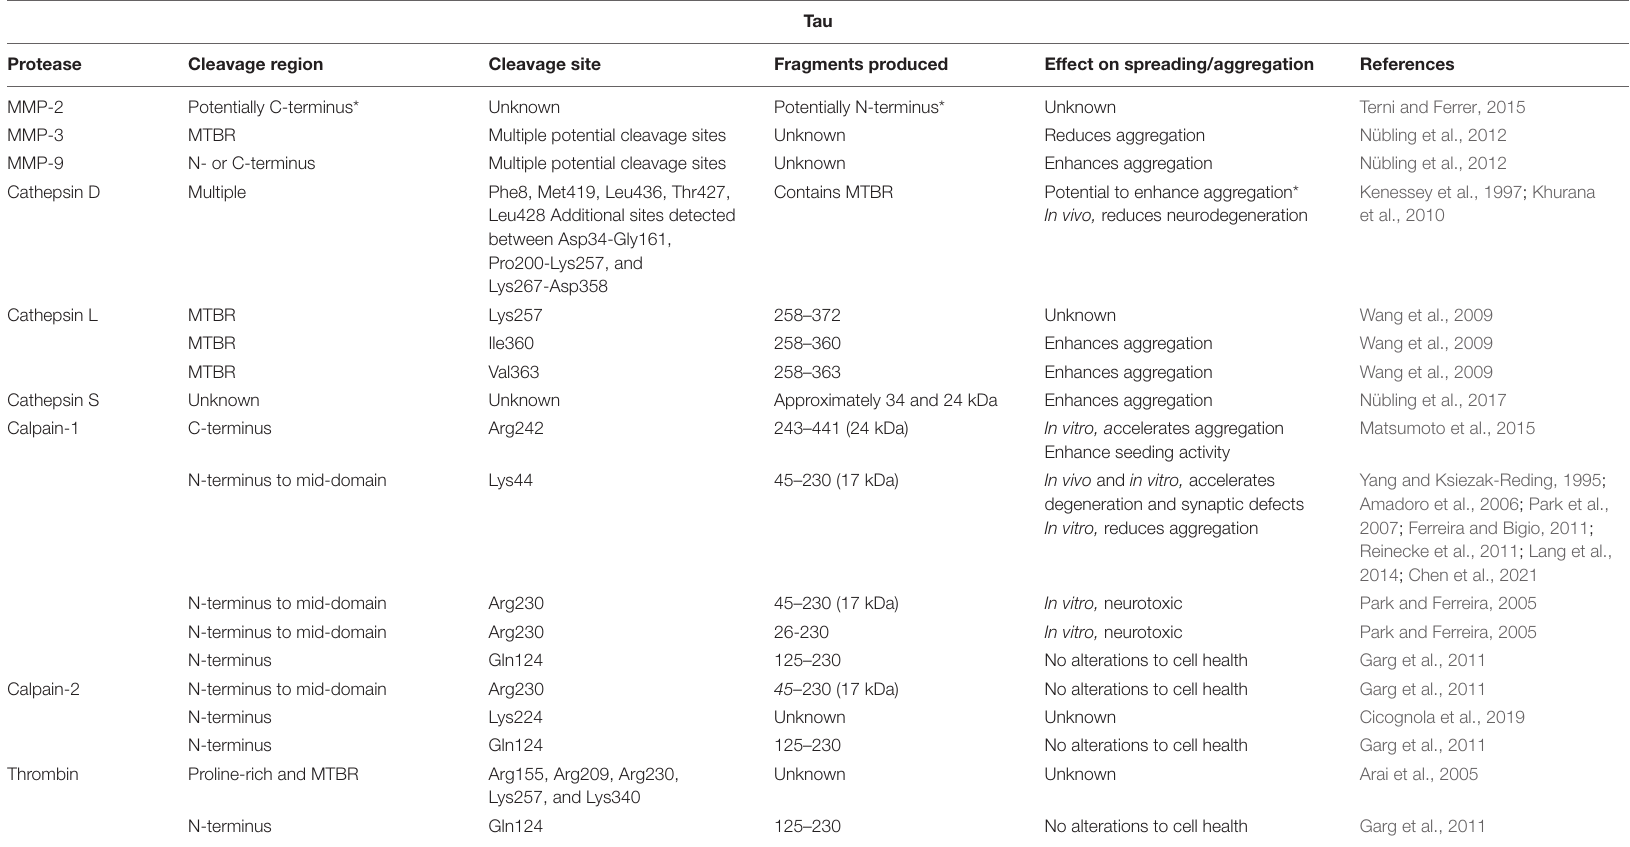
TABLE 1 | This table summarizes the known extracellular proteases of prion-like proteins, their region and site of cleavage, the resulting fragment and the effect of their activity on spreading and aggregation of the pathological